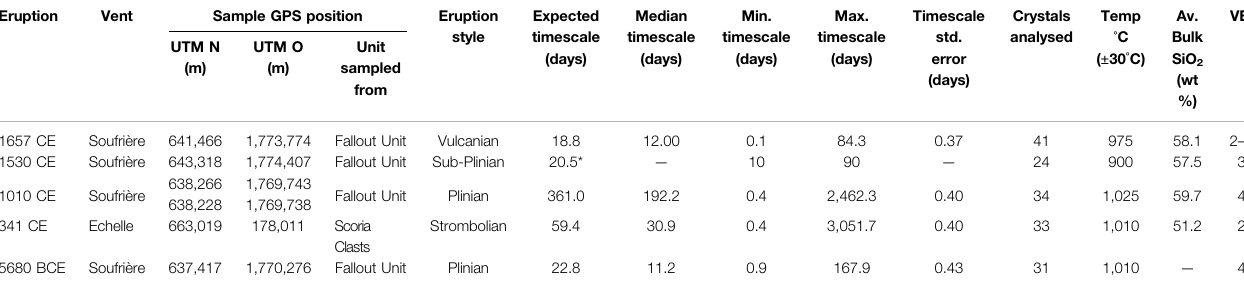
The crystal number refers to the number of crystals diffusion timescales were calculated on [*Mean timescale not expected timescale, calculated from available data Bourgeoisat (2018); Boudon et al. (2008); Pichavant et al. (2018)].